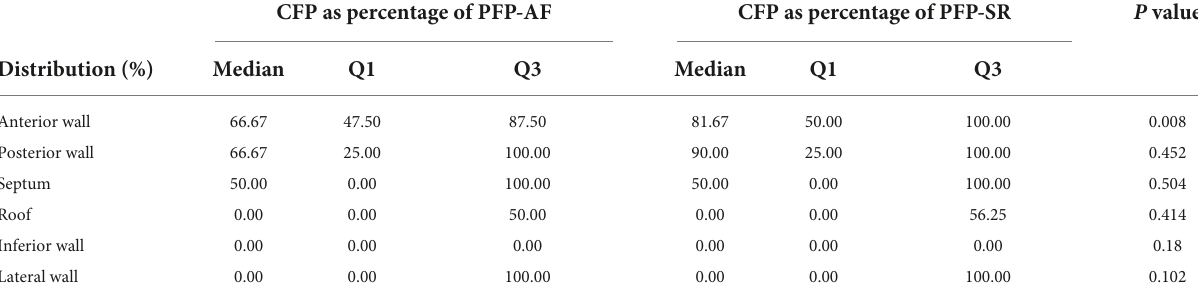
TABLE 3 Percentage of concordance of fractionated potentials (CFP) in prolonged fractionated potentials-atrial fibrillation (PFP-AF) and prolonged fractionated potentials-sinus rhythm (PFP-SR). CFP as percentage of PFP-AF CFP as percentage of PFP-SR P